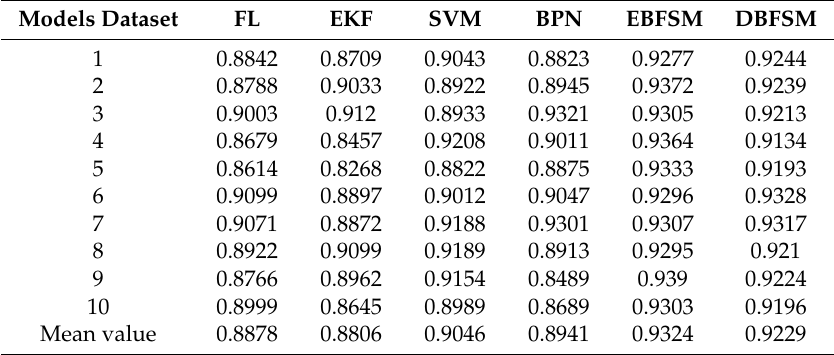
Table 8. Comparison of different models for overall